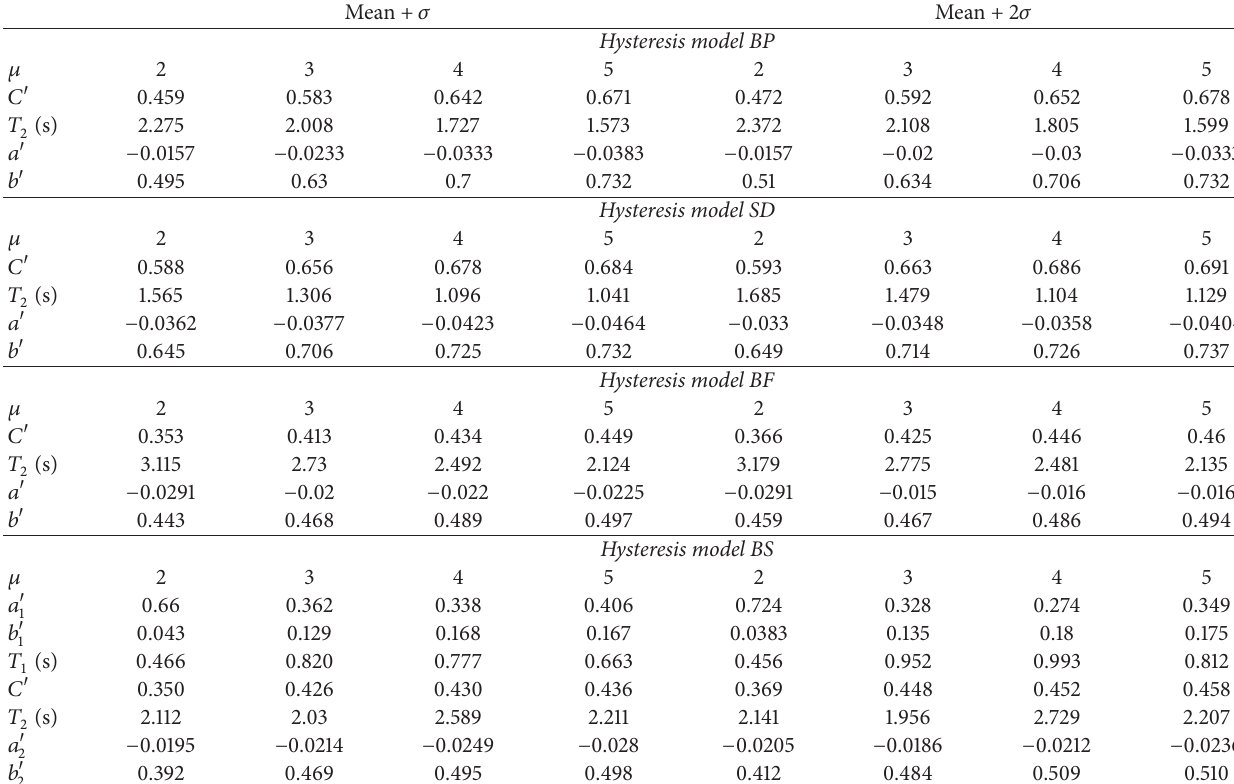
Table 12: HE/IE spectral shape parameters for soil site class B.